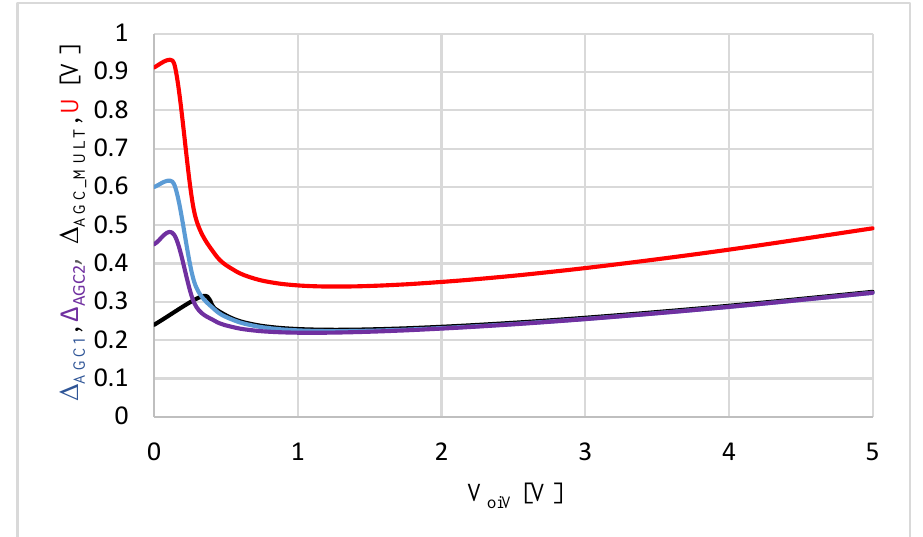
Figure 8. Total error of the AGC structure based on the microprocessor, where Δ AGC_MULT is the limiting error of AGC structure with an analog multiplier, Δ AGC1 is the limiting error of the AGC structure implemented on a microprocessor (Figure 4), Δ AGC2 is the limiting error of the AGC structure implemented on a microprocessor with a more accurate amplifier (Figure 4), U is the uncertainty, and V oiv is the value of the input signal.